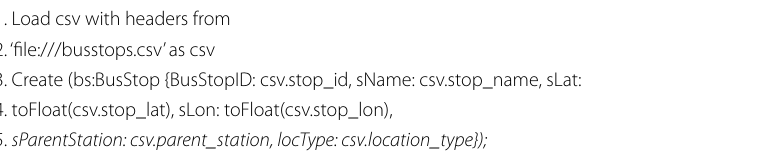
Table 2 Cypher query used to create Bus Stop nodes in the Platial